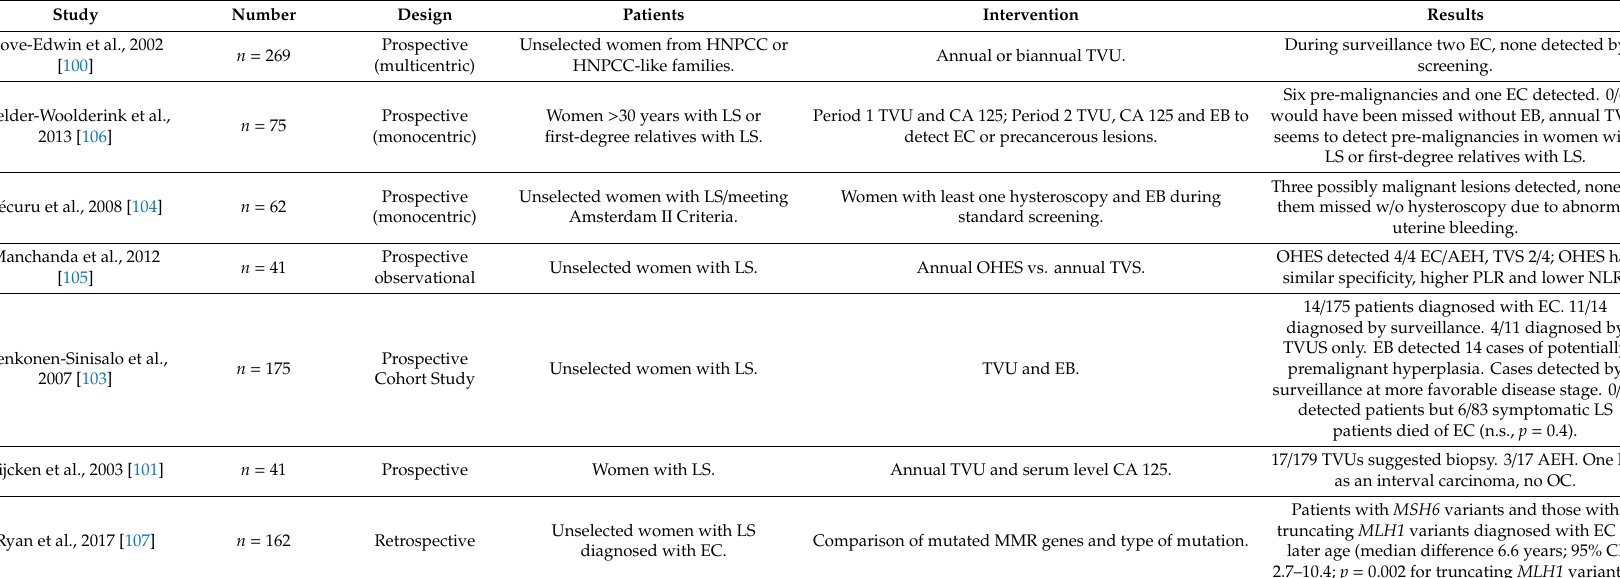
Table 3. Studies on di ff erent gynecologic surveillance strategies in families with hereditary